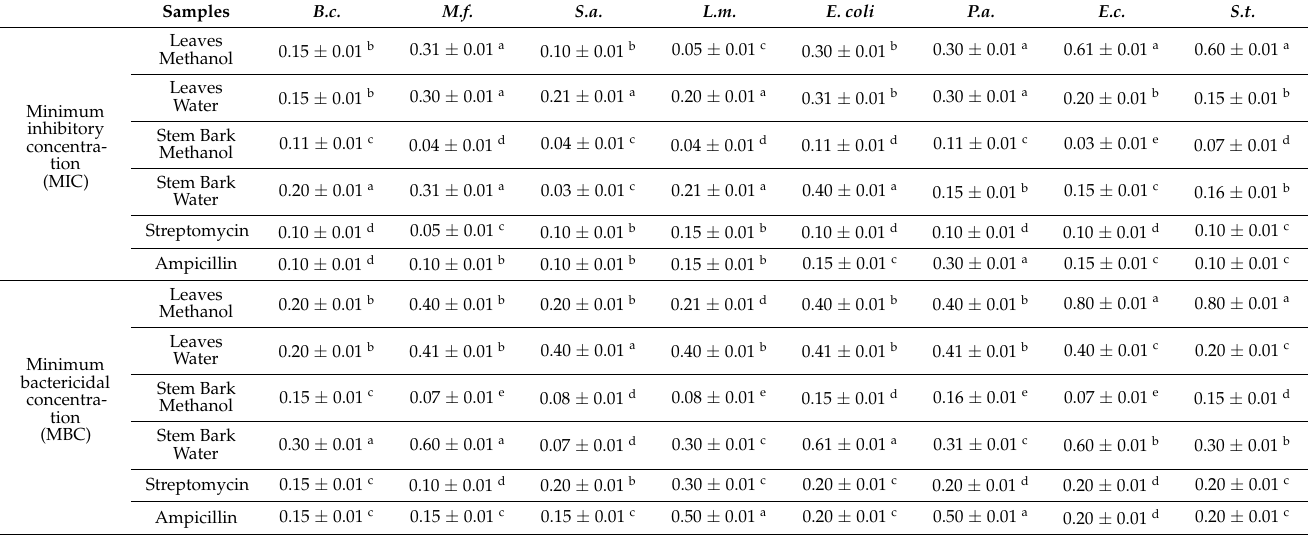
Table 6. Antibacterial activity of P. kotschyi samples (mg/mL)